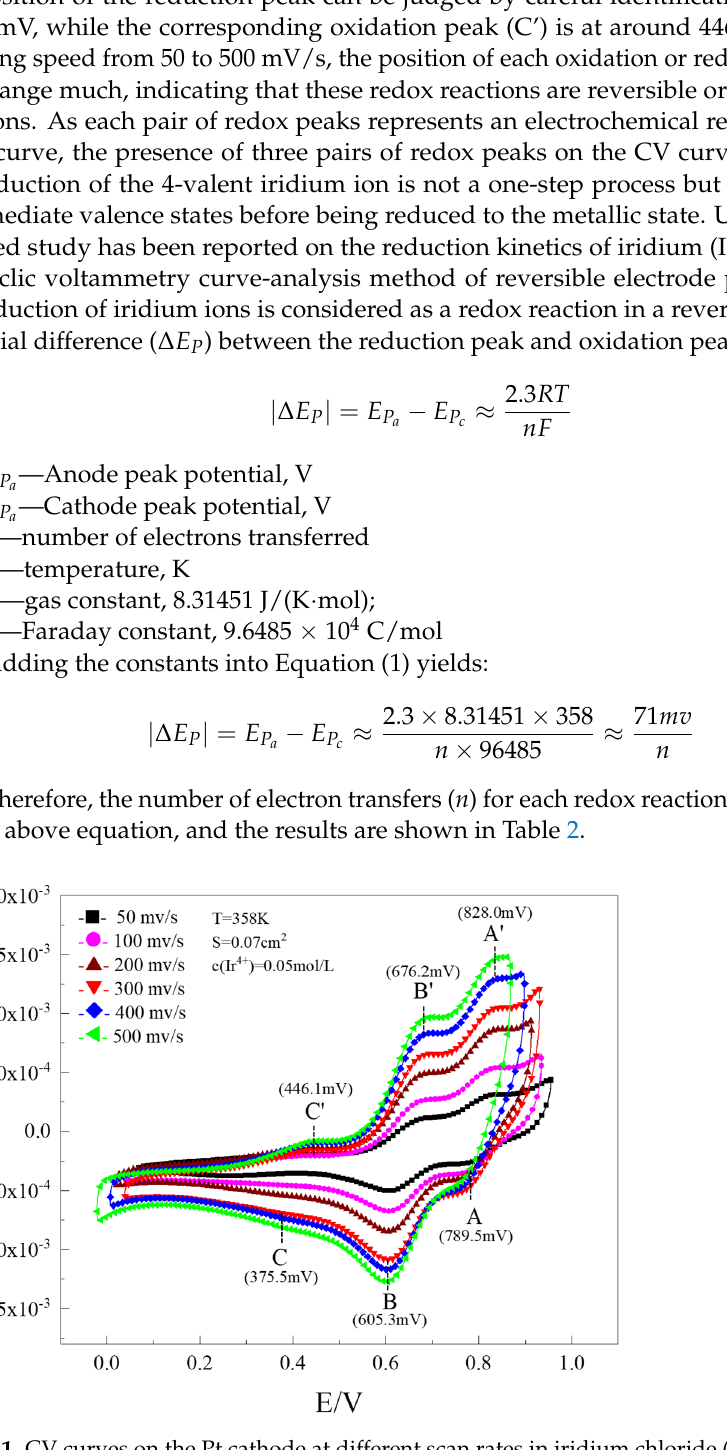
Table 2. Calculation of electron transfer number ( n ) for each redox reaction.